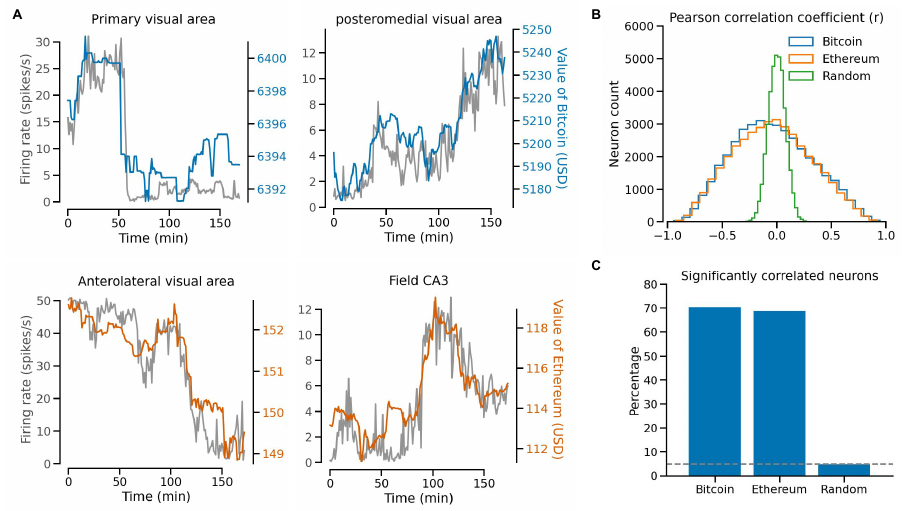
Figure 1 – Neural correlate of cryptocurrency price. ( A ) Example neurons from four different brain regions which showed a strong correlation with ongoing price fluctuations of Bitcion (top) and Ethereum (bottom). Spike rate and cryptocurrency price was binned in 60 second bins. ( B ) Distribution of Pearson correlation coefficients was centered at zero but showed a large fraction of neurons that were positively and negatively correlated with cryptocurrency price. Correlation with a vector of random numbers was added as a control. ( C ) A high percentage of neurons showed a significant correlation with Bitcoin or Ethereum price ( p < 0.05), in contrast only 4.9% of neurons were correlated with the random vector, close to the Type I false positive rate of 5% (grey dotted